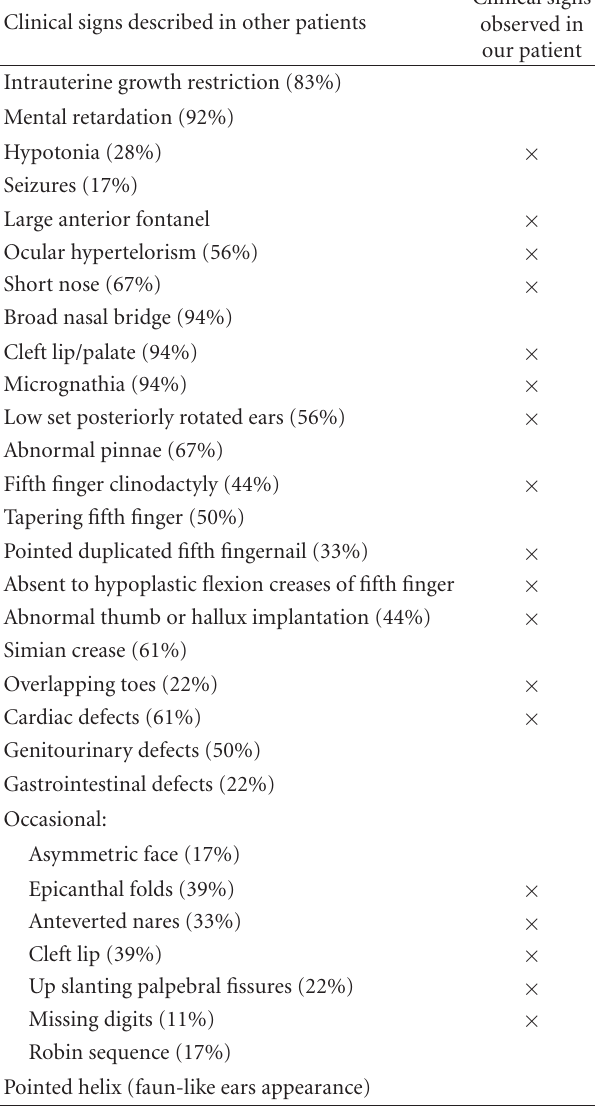
Table 1: Clinical signs in this patient previously described in the